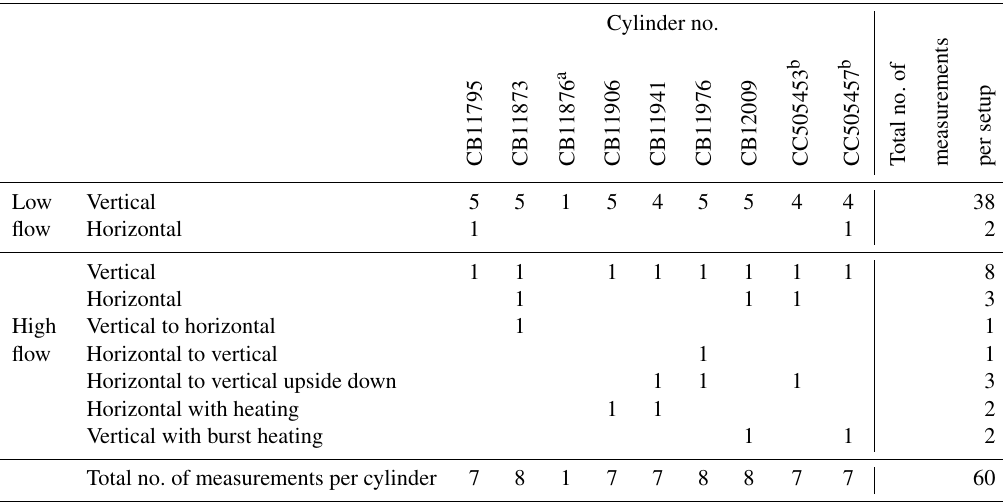
Table 1. List of the cylinders used in this study and numbers and types of experiments done with each of them.